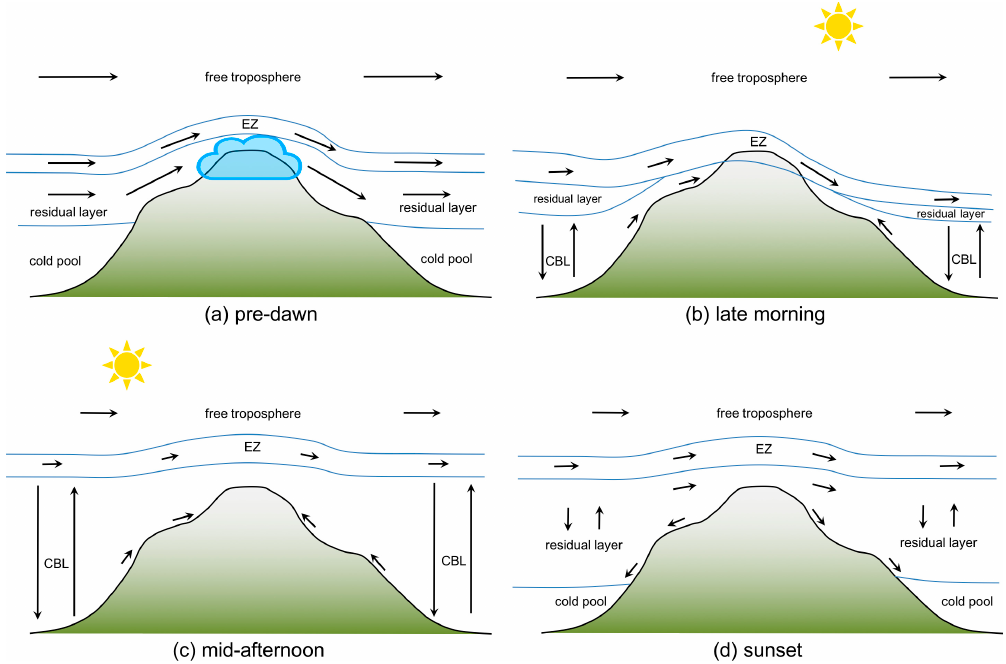
Figure 9. Conceptual diagram of each phase of Mount Washington summit air mass exposure on 19 August 2016. ( a ) Before sunrise, residual layer air from over the western valley is pushed upslope to the summit by strong winds. An orographic cloud formed in this upslope flow. Note that the residual layer and entrainment zone (EZ) were pushed locally higher by the mountain causing the summit to remain in the residual layer. ( b ) By late morning, the convective boundary layer (CBL) developed and entrained most of the residual layer. Wind speed decreased and large-scale subsidence increased in association with the cresting of the high pressure ridge. As a result, the orographic cloud diminished and the EZ descended to the summit. Isentropic drawdown and/or mechanical mixing brought the EZ to lower elevations on the lee (east) side of the mountain. ( c ) During the early to mid afternoon, the CBL grew upward beyond the summit elevation placing the summit in the CBL for several hours. ( d ) During the late afternoon through sunset, surface cooling commenced and began developing a nocturnal cold pool. Large scale winds remained light and the residual layer remained at the summit through the end of the observation period.